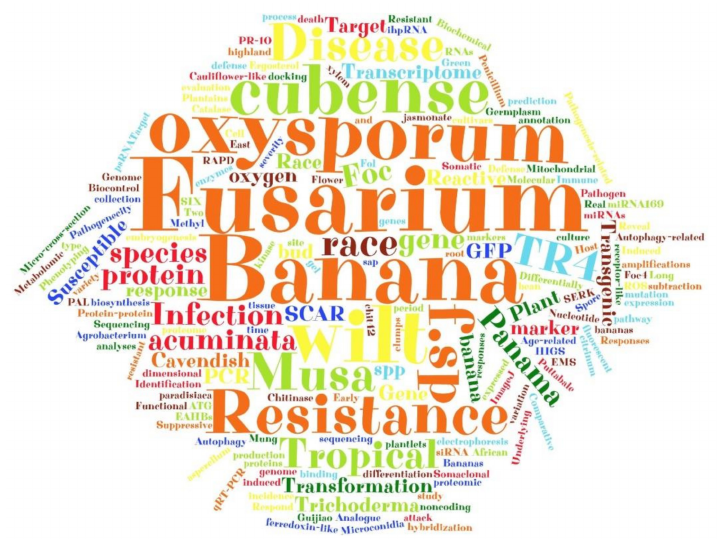
Figure 3. Word cloud generated from article keywords of selected articles to compose a systematic review on breeding Musa to Fusarium wilt. The word cloud was created in a free online generator (https://www.wordclouds.com/, accessed on 16 August 2020), based on the frequency of each keyword.